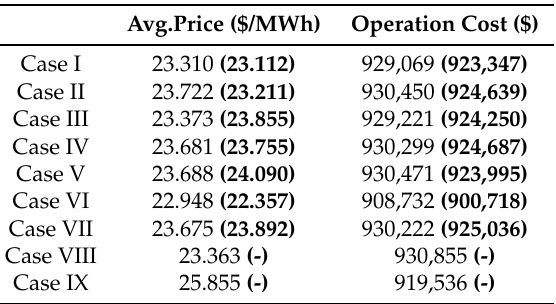
Table 5. Summary of electricity price and operation cost; deterministic